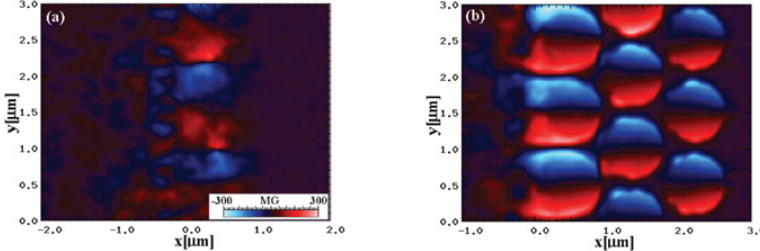
Figure 4. Electron density profiles for (a) density trough target and (b) punched target.